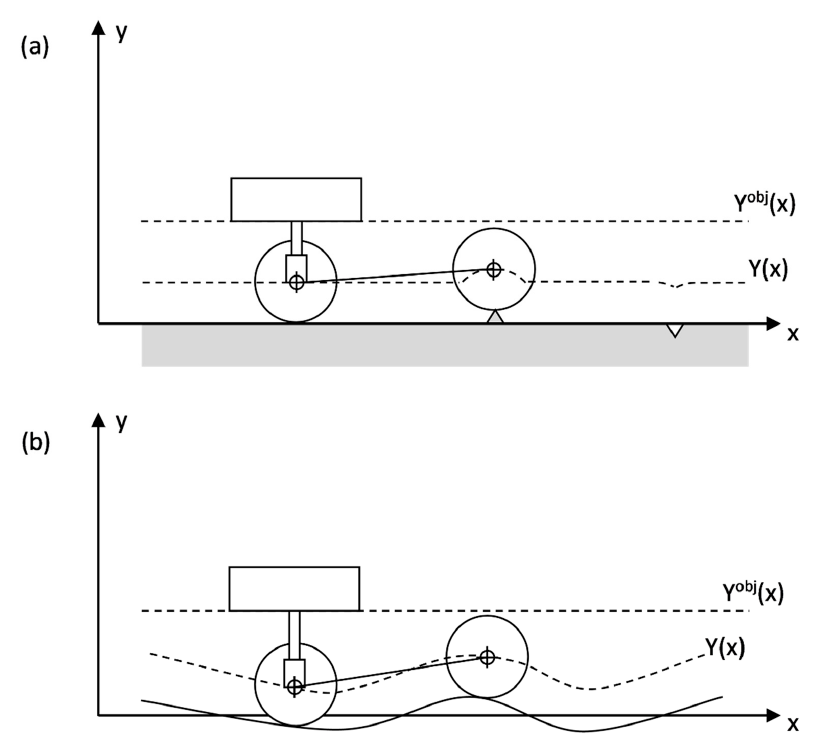
Figure 3. Two kinds of terrain defects: ( a ) peak defects and ( b ) smooth or corrugated terrain.